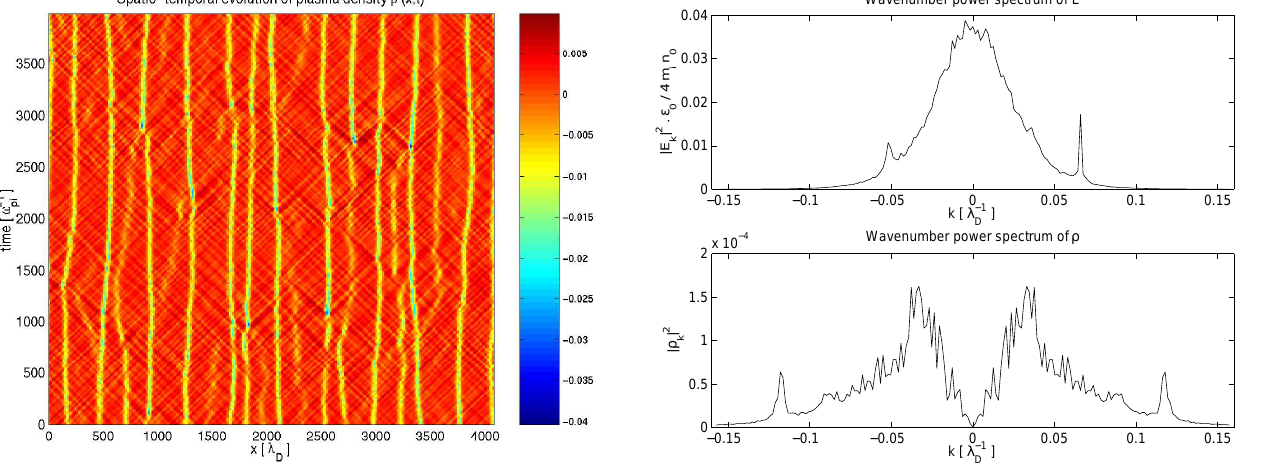
Fig. 2. Excerpt of the spatio-temporal dynamics of the electron den- sity. The cavities move very slowly and they conserve their almost periodic spatial distribution.